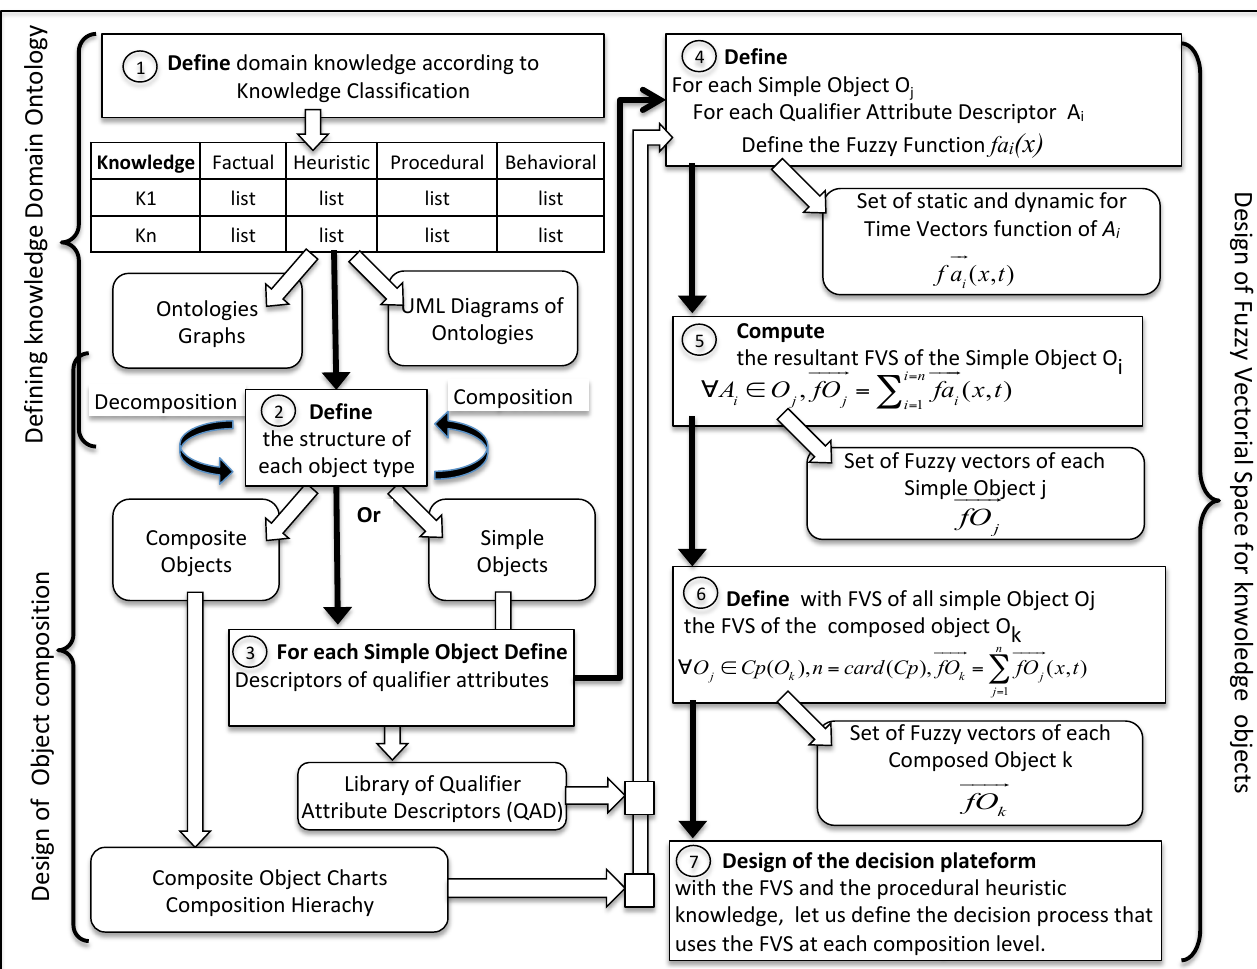
Figure 3. A method to design artificial intelligence (AI) decision support systems with fuzzy vecto- rial